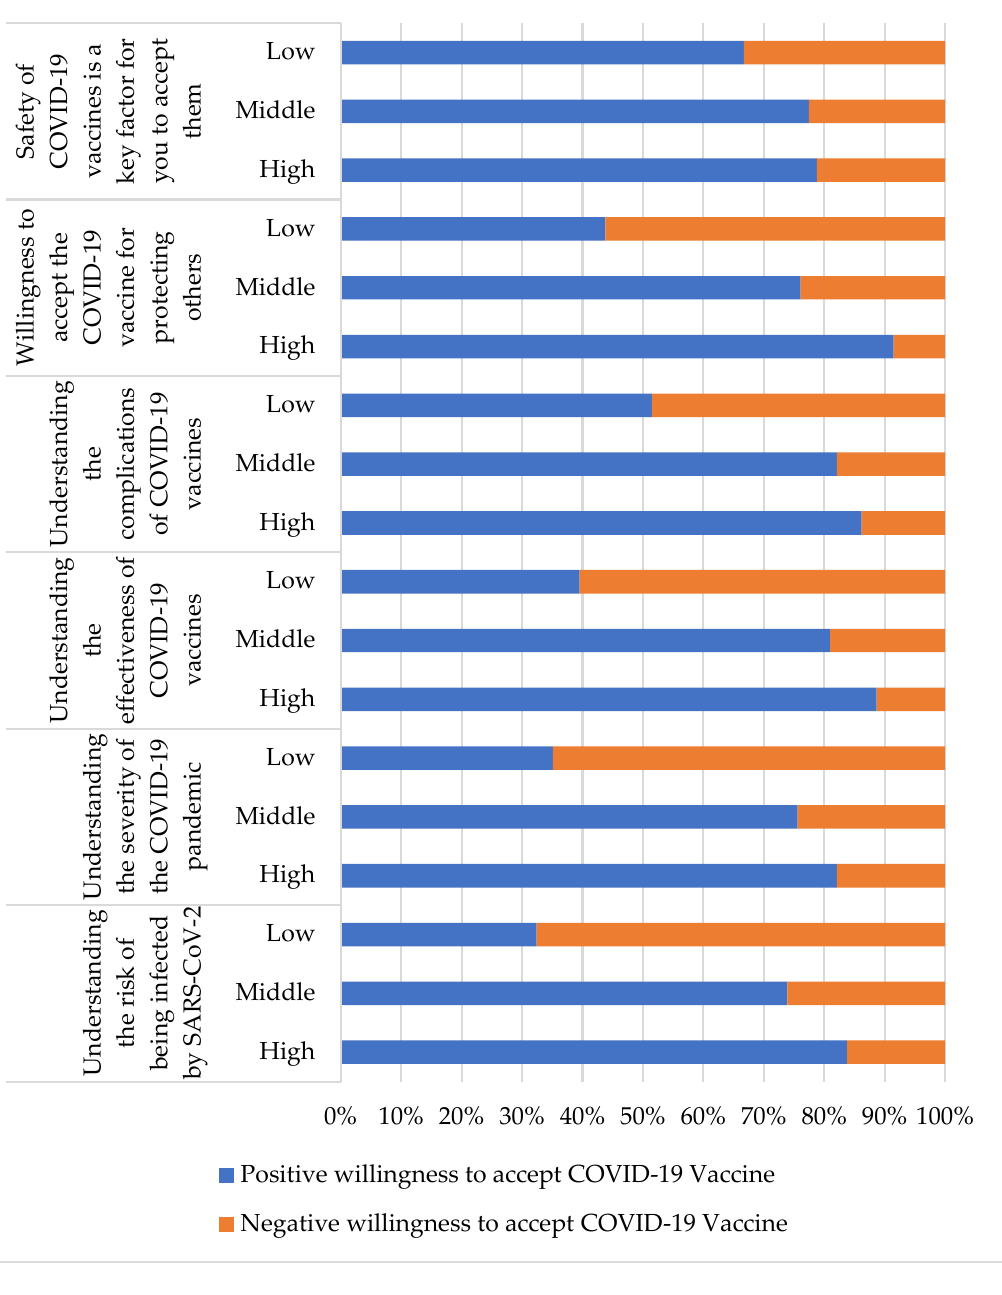
Figure 1. The percentages of positive and negative willingness to accept COVID-19 vaccine for each item in Table 2.